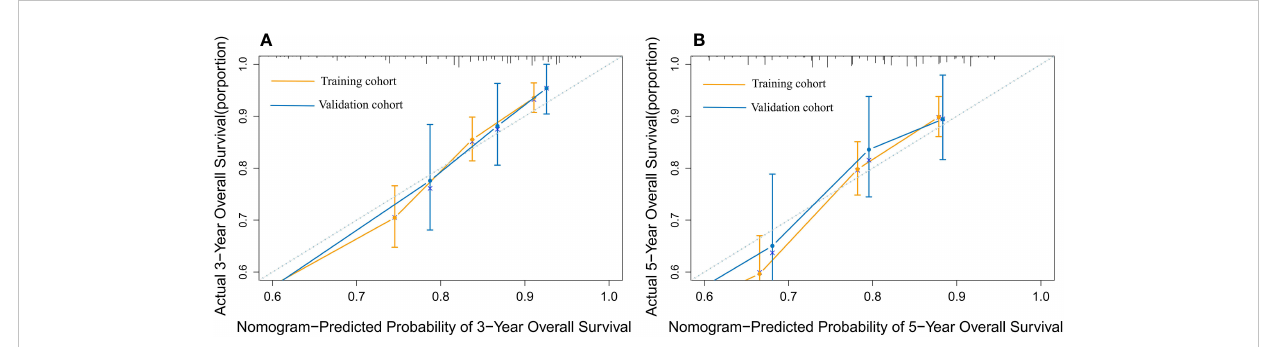
FIGURE 4 The calibration plot for predicting 3- and 5-year overall survival for patients with MBC. Calibration plot of nomogram prediction of (A) 3-year and (B) 5-year OS of patients with MBC in the training and validation I sets.